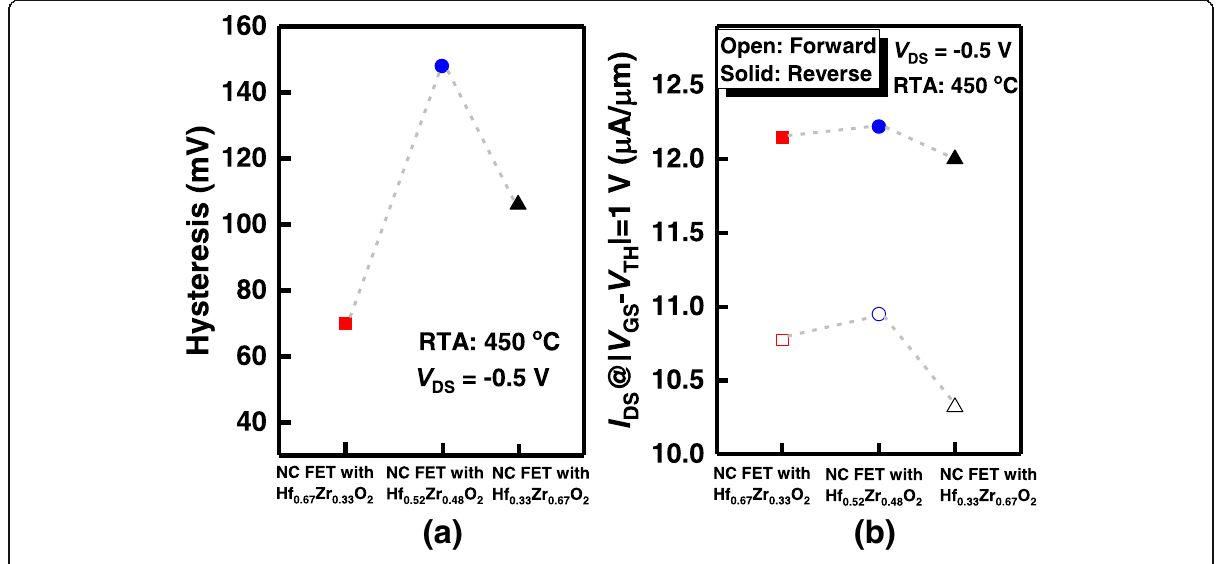
Fig. 8 Statistical plots of ( a ) hysteresis and ( b ) I DS of Ge NCFET with Hf 1 − x Zr x O 2 ( x = 0.33, 0.48, and